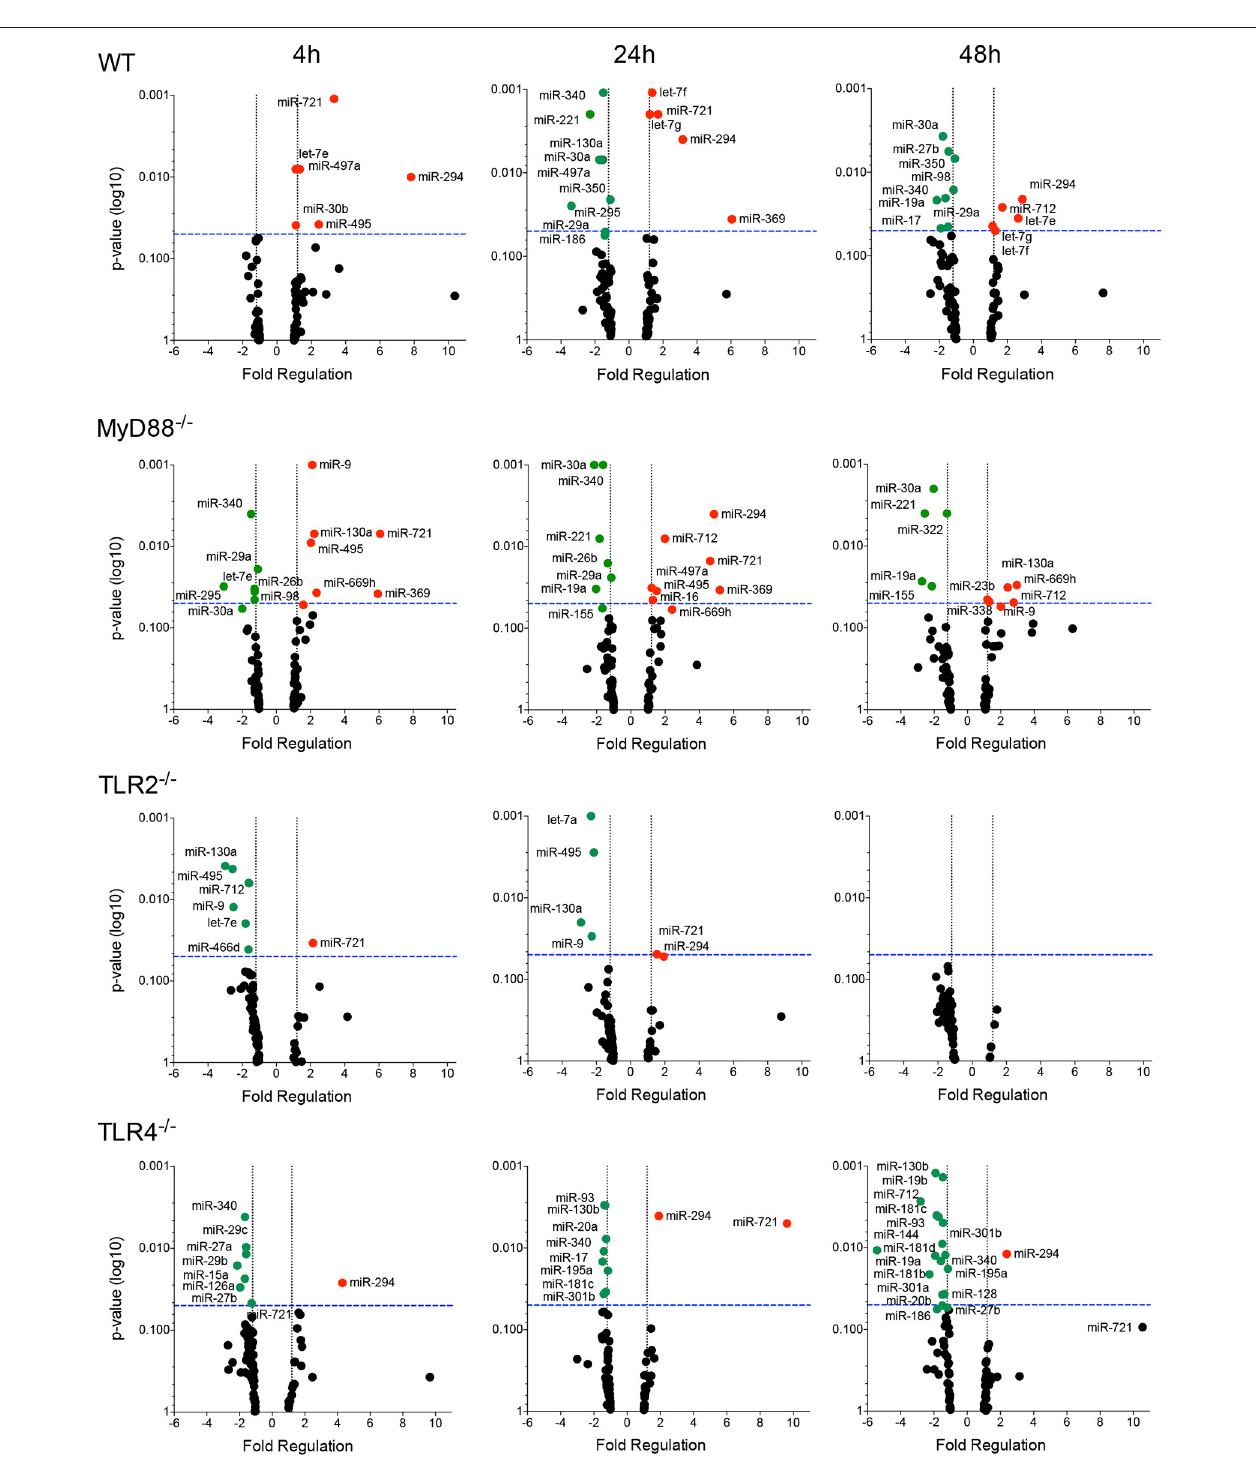
FIGURE 3 | Volcano plot of the miRNA profiles of macrophages from WT, MyD88, TLR2 and TLR4 null mice infected with L. amazonensis . Each dot represents the level of one miRNA in BMDMs from WT, MyD88 − / − , TLR2 − / − , or TLR4 − / − mice infected with L. amazonensis for 4, 24, and 48h. The red dots indicate upregulated miRNAs and green dots indicate downregulated miRNAs. The blue dotted line corresponds to p = 0.05, log 10. The relative upregulation and downregulation of miRNAs are presented as boundaries of 1.2 or − 1.2 of Fold Regulation, respectively. P -values were determined using two-tailed Student’s t -tests. Representative data from three independent experiments are